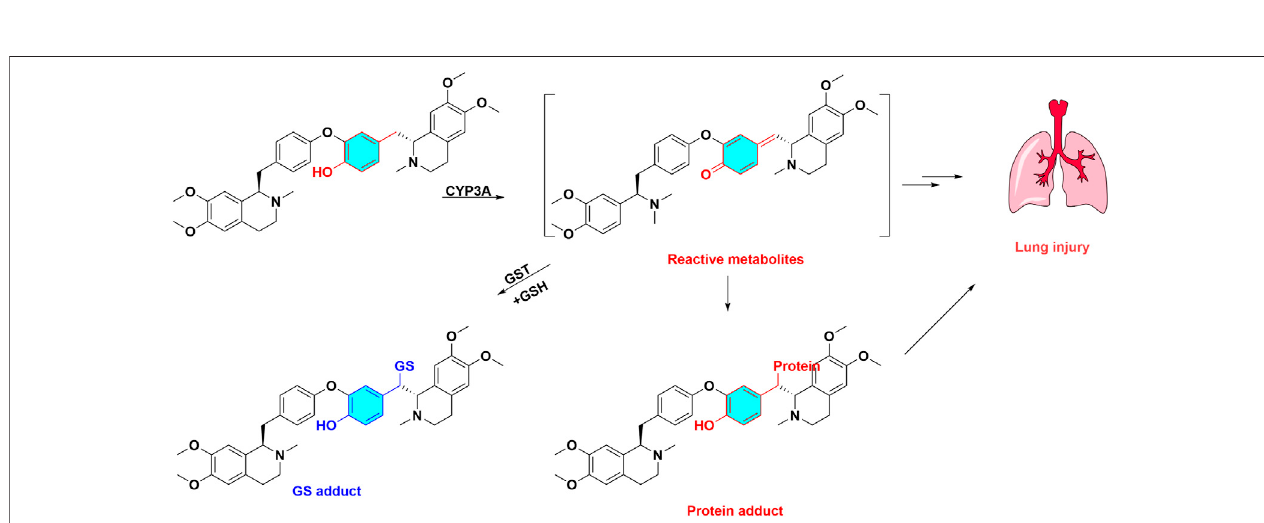
FIGURE 4 | Metabolic activation and toxicity of dauricine. Dauricine are biotransformed quinone methide intermediate catalyzed by CYP3A, these reactive metabolites capture GSH and protein, then produce GSH adduct, protein adduct, at last led to lung injury.